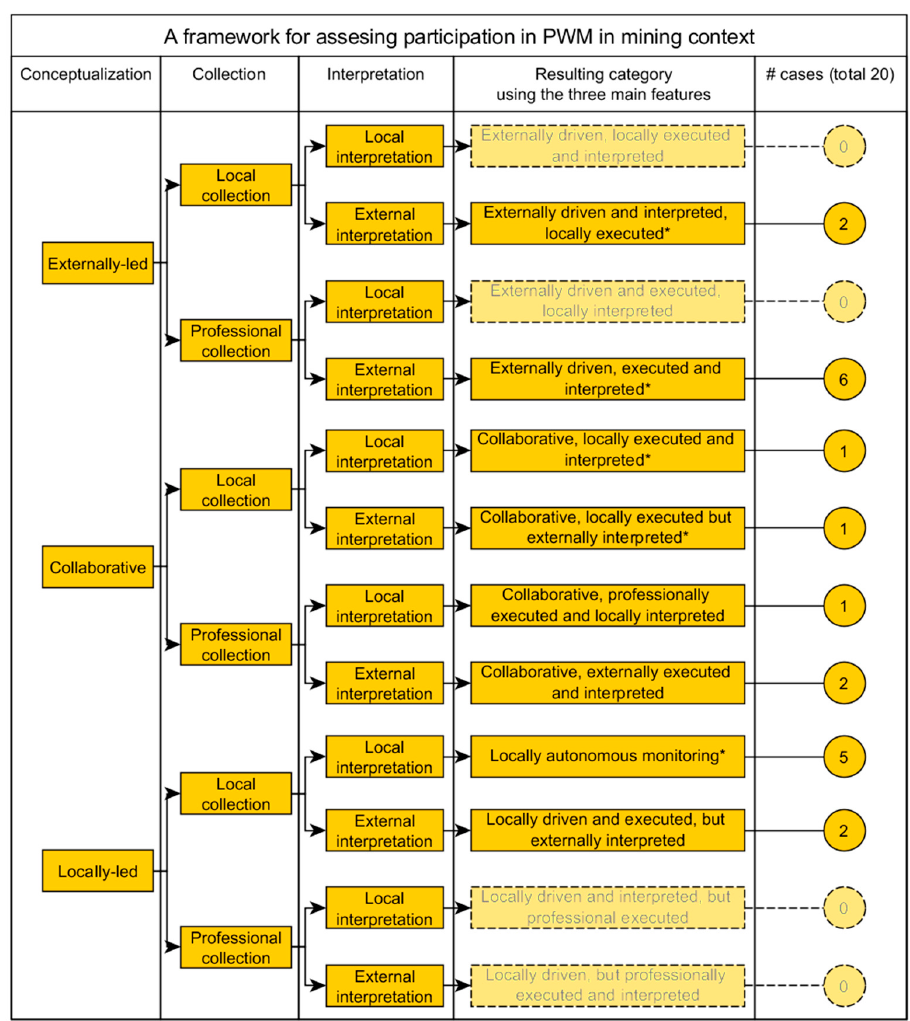
Figure 1. Proposed framework for PWM is based on partly conceptualizing the program (first column), actor collecting the data (second column) and data interpreter (third column). Categories that are consistent with the framework in Reference [31] are marked with an asterisk. Categories that were not found in the sample are shown as transparent. Circles represent the number of cases identified.